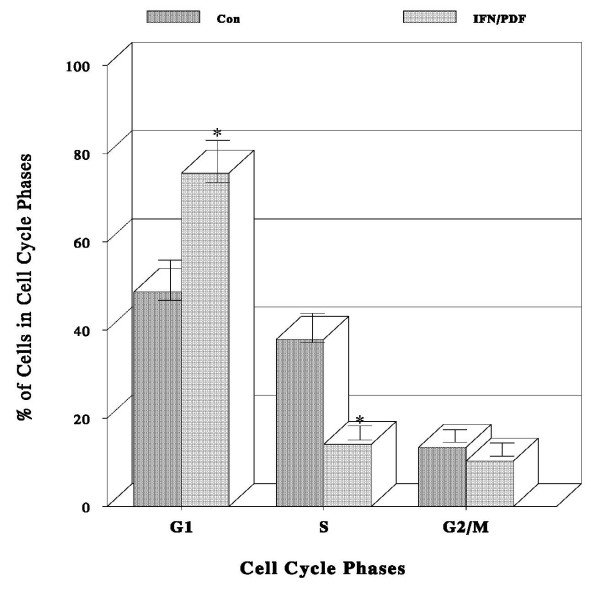
Cell cycle analysis. Cells were cultured with IFN-α2b (10 K IU/ml), PDF (250 μg/ml), or their combination for 72 h, and they were subjected to cell cycle analysis as described in Materials and Methods. IFN-α2b or PDF alone had little effects on cell cycle phase distribution similar to that in control cells. However, the IFN/PDF combination resulted in significant changes (*p < 0.05) in cell populations in the G1 and S phases compared to controls, as shown here.